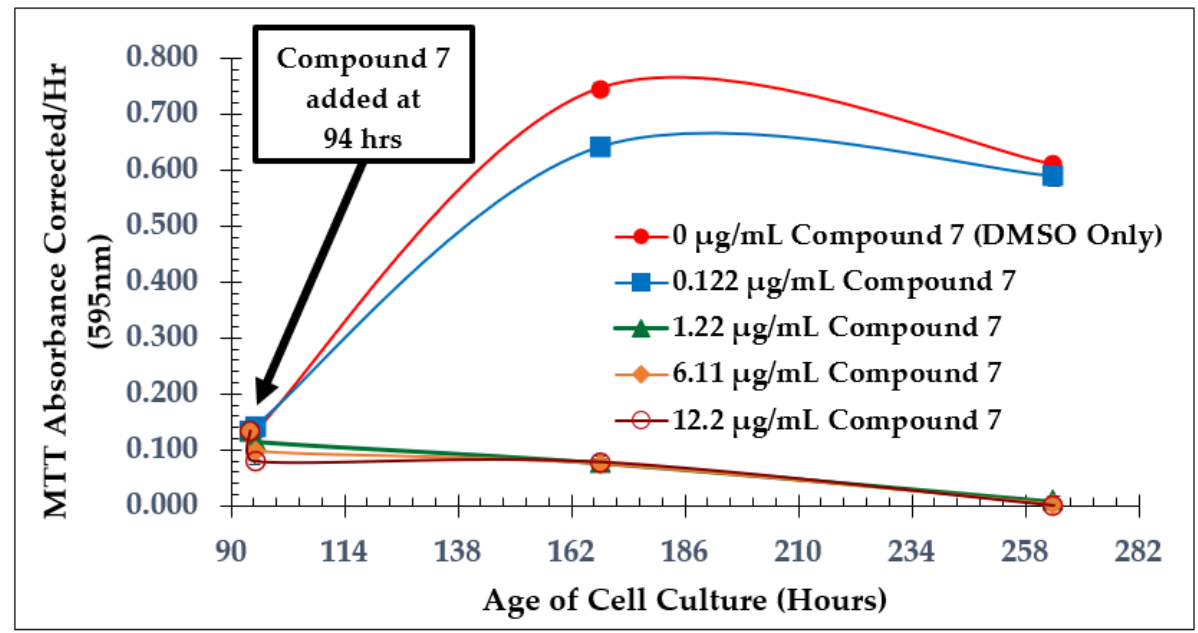
Figure 6. Dose-Dependent Effect of Compound 7 on L. tarentolae . Additions at 94 h; Values are the mean and standard deviation for n = 4 replicates; in some cases, the SD error bars are difficult to see since they are small relative to the circle or square size used.